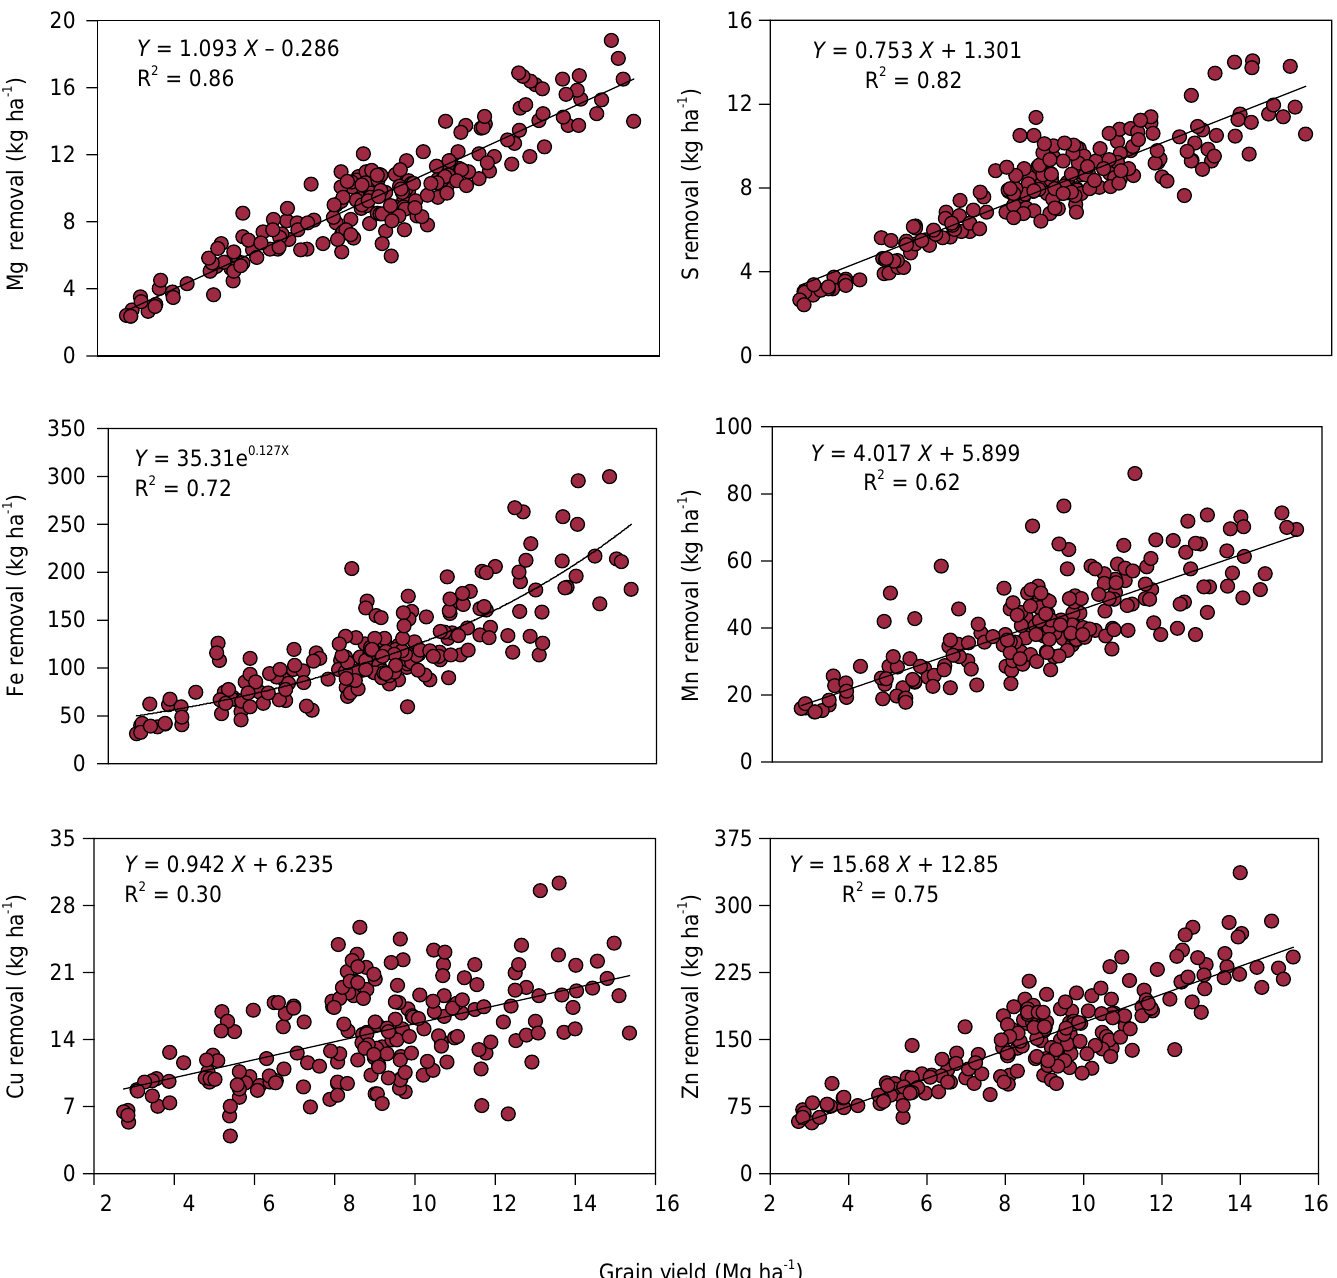
Figure 3. Removal of magnesium, sulfur, iron, manganese, copper, and zinc related to corn grain